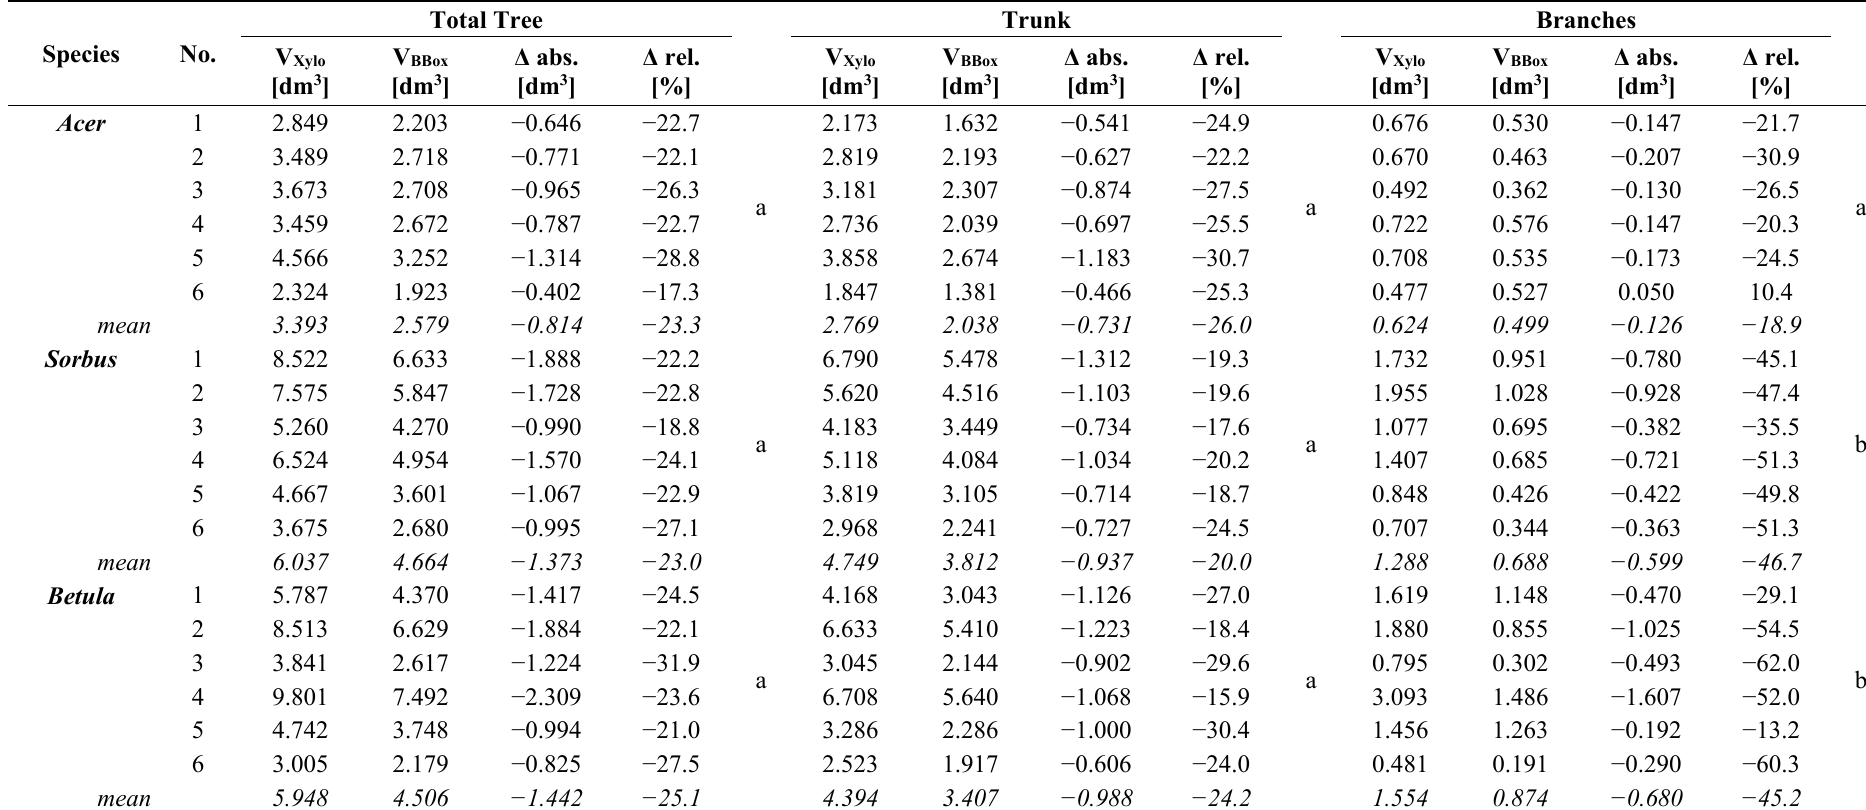
Table 3. Xylometric volume measurements (V Xylo ) and bounding box volume estimates (V BBox ) for each tree and point cloud (total tree, trunk and branches), resulting absolute (Δ abs. = V BBox − V Xylo ) and relative differences (Δ rel. = (V BBox − V Xylo ) / V Xylo × 100) and their mean values. Different lower case letters indicate significant differences between tree species in post hoc Tukey tests ( p <